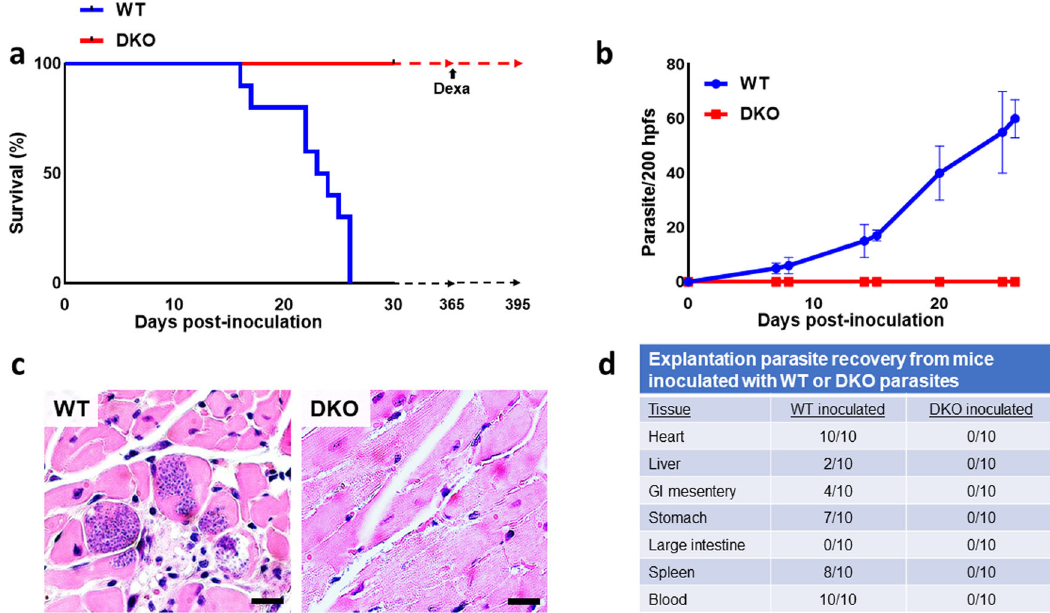
Fig. 3 Inoculation of mice with T. cruzi cell lines. a Survival curve of mice inoculated with WT and DKO cell-culture-derived metacyclic trypomastigotes (10 5 intraperitoneally per mouse. n = 20) demonstrate that WT parasites kill all mice within ~21 days, inoculation of mice with DKO parasites does not result in clinical infection up to one-year post-inoculation, in all groups. DKO-inoculated animals (2 experiments of 5 animals each) which had been observed for one year, treated with dexamethasone (Dexa) did not develop clinical disease, alter survival or cause the emergence of parasites from blood or tissues in 100% of the animals (Supplementary Fig. 13). b Parasitemia of mice inoculated with WT or DKO parasites ( n = 10 mice per assay). c Histopathologic analysis of heart sections of mice inoculated with WT (left) taken from mice at or near the time of death at 21 days or DKO parasites (right) harvested at 6 months post-infection. d Explantation of indicated tissues in parasite culture medium from mice either at or near time of death (for WT-inoculated animals) or 6 months (for DKO-inoculated animals) post- infection. This is a compilation of data from two separate experiments with comparable results (5 mice per group in each experiment, n = 10). Student t-test was used for parasitemia. P < 0.05 in panel b . The log-rank (Mantel-Cox) test was used for Kaplan – Meier survival